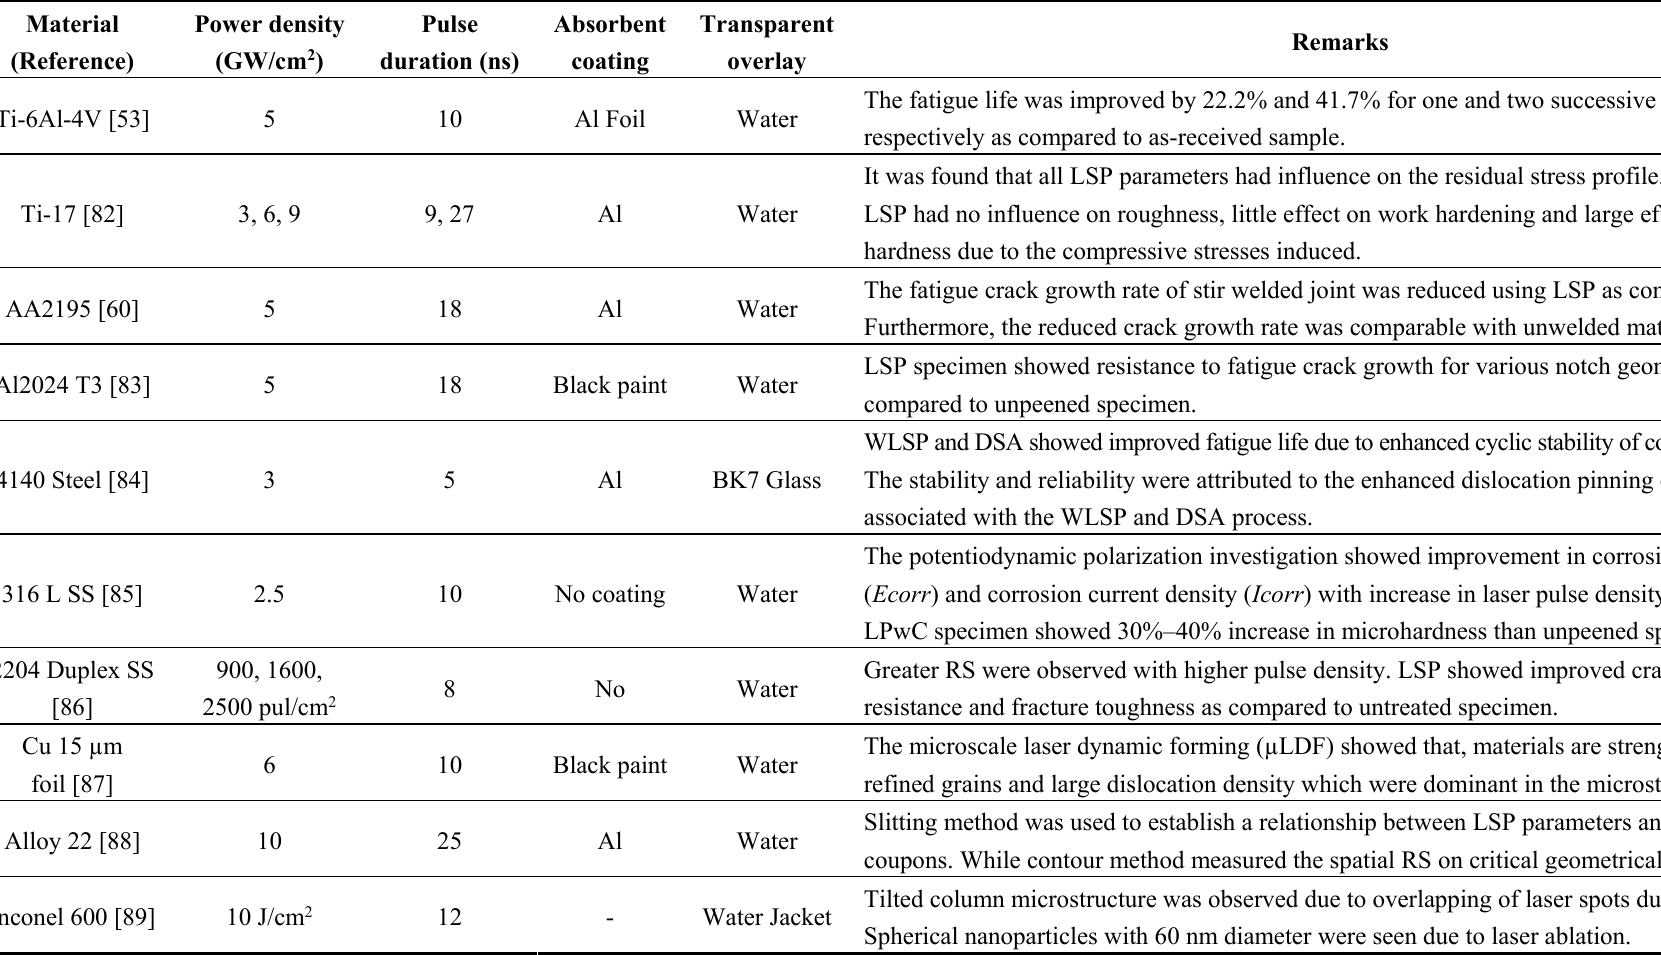
Table 2. Typical LSP processing parameters from the literature used for different materials with concluding